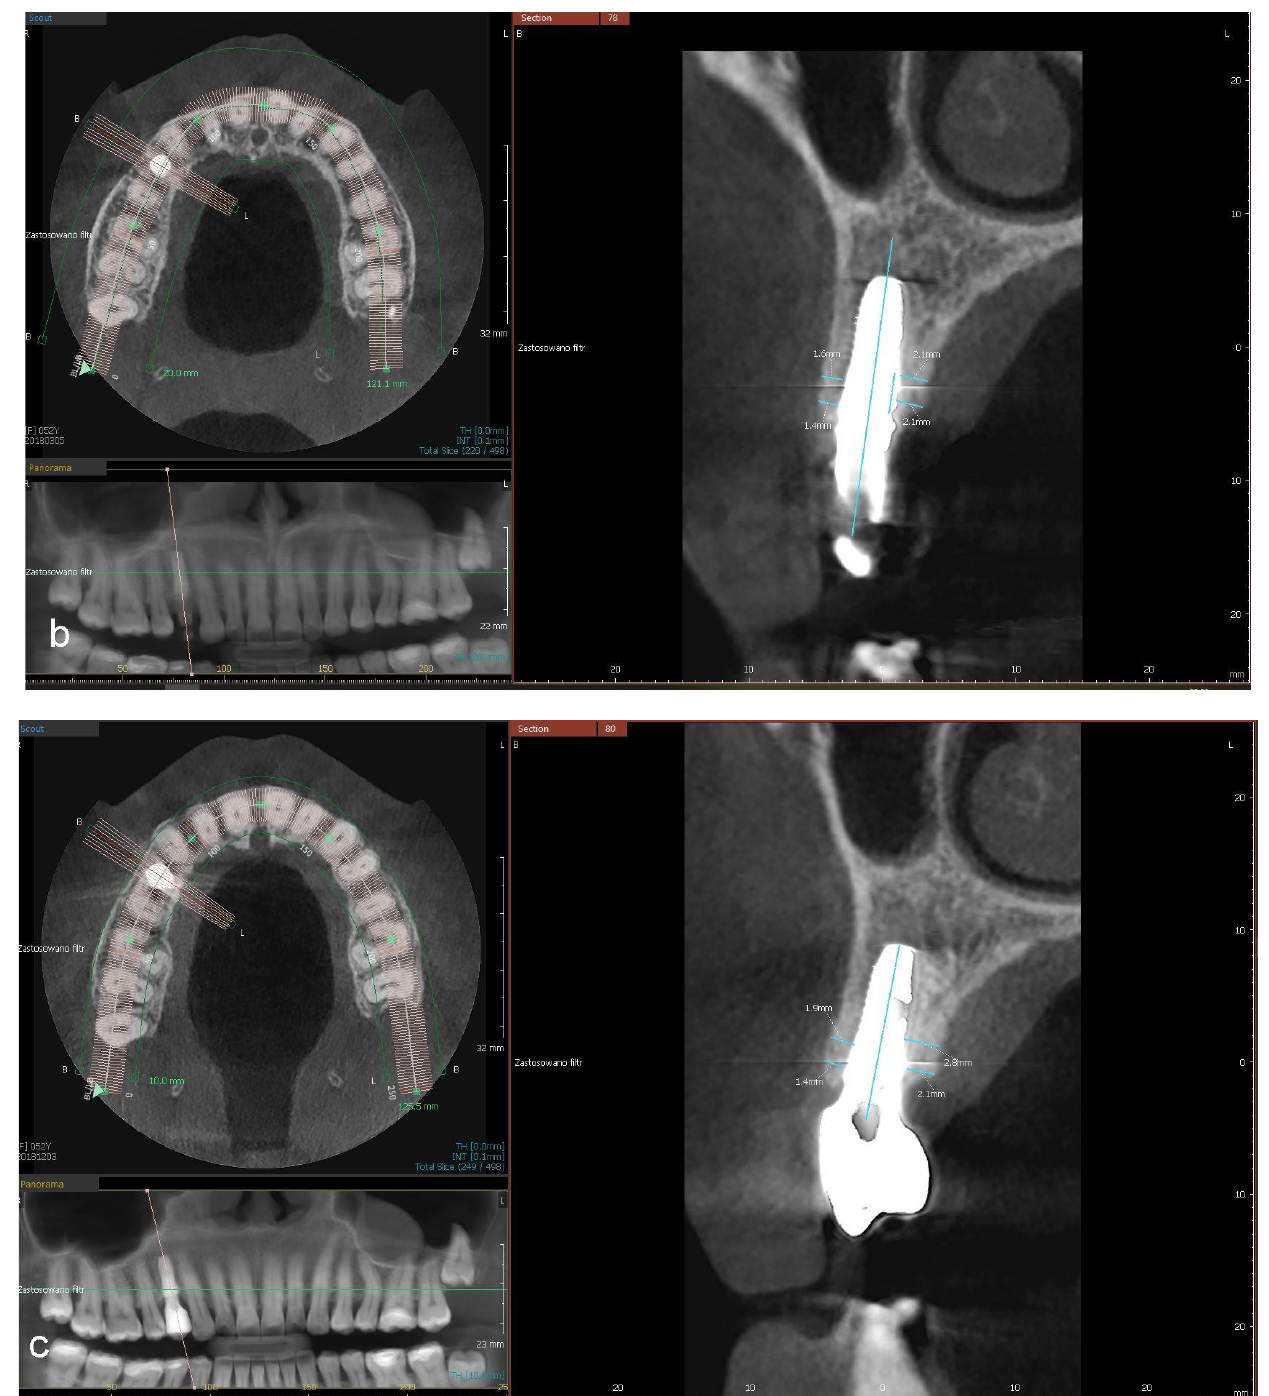
Figure 1. ( a ) CBCT scan taken immediately after implant insertion at position 14. At the measurement point located 1 mm from the implant shoulder: BP = 1.8 mm, PP = 1.8 mm. At the measurement point located 3 mm away from the implant shoulder: BP = 2 mm, PP = 2.6 mm. ( b ) Scan of the implant after the provisional crown delivery. At the measurement point located 1 mm from the implant shoulder: BP = 1.4 mm, PP = 2.1 mm. At the measurement point located 3 mm away from the implant shoulder: BP = 1.6 mm, PP = 2.7 mm. ( c ) Scan of the implant after placement of the definitive crown. At the measurement point located 1 mm from the implant shoulder: BP = 1.4 mm, PP = 2.1 mm. At the measurement point located 3 mm away from the implant shoulder: BP = 1.9 mm, PP = 2.8 mm. The Pink Aesthetic Score ranged between 3 implant insertions (Median = 5) at TCD.